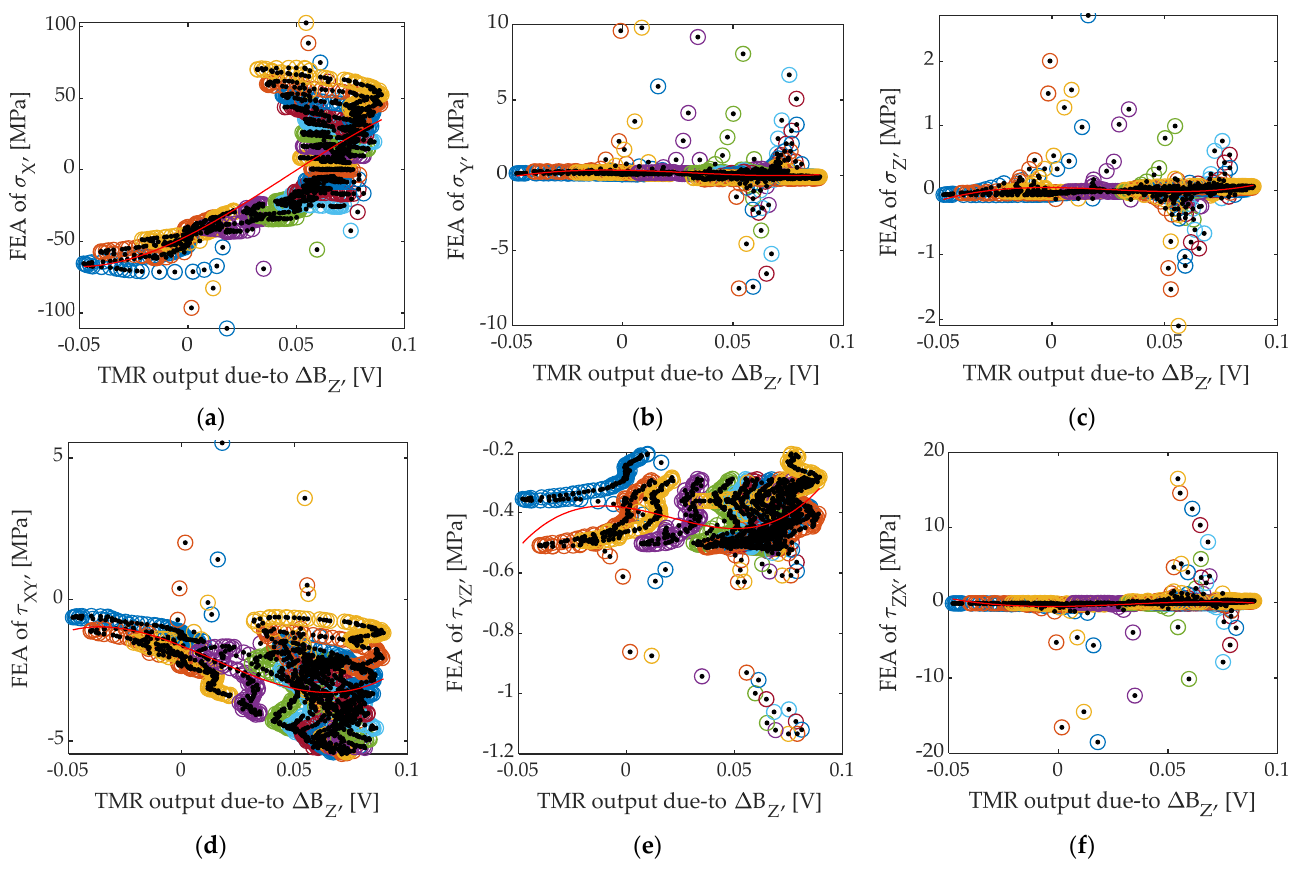
Figure 10. FEM analysis versus experimental results of the differential magnetic flux density ( ∆ B Z ) on the area of interest: ( a ) FEM analysis of σ X vs. ∆ B Z ; ( b ) FEM analysis of σ Y vs. ∆ B Z ; ( c ) FEM analysis of σ Z vs. ∆ B Z ; ( d ) FEM analysis of τ XY vs. ∆ B Z ; ( e ) FEM analysis of τ YZ vs. ∆ B Z ; ( f ) FEM analysis of τ ZX vs. ∆ B Z The approximated data by the Equation (7) study the relationship between the stress and shear stress versus the differential magnetic flux density. The error between the ap- proximated data and the experimented data is expressed by the following formula: